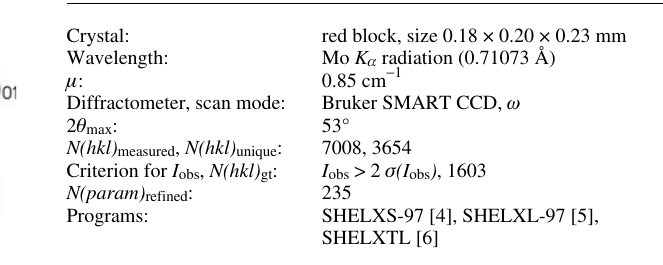
Table 1. Data collection and handling.